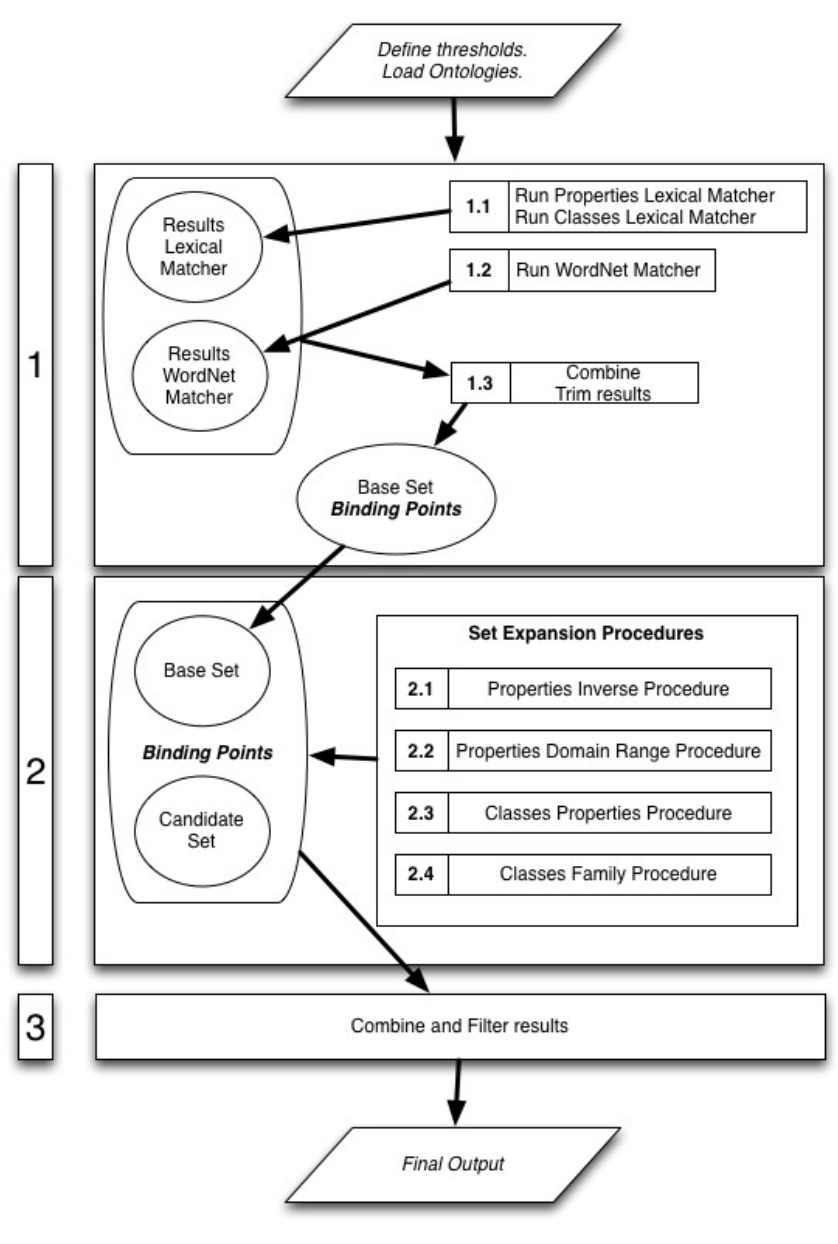
Figure 2. Schematic diagram of algorithm